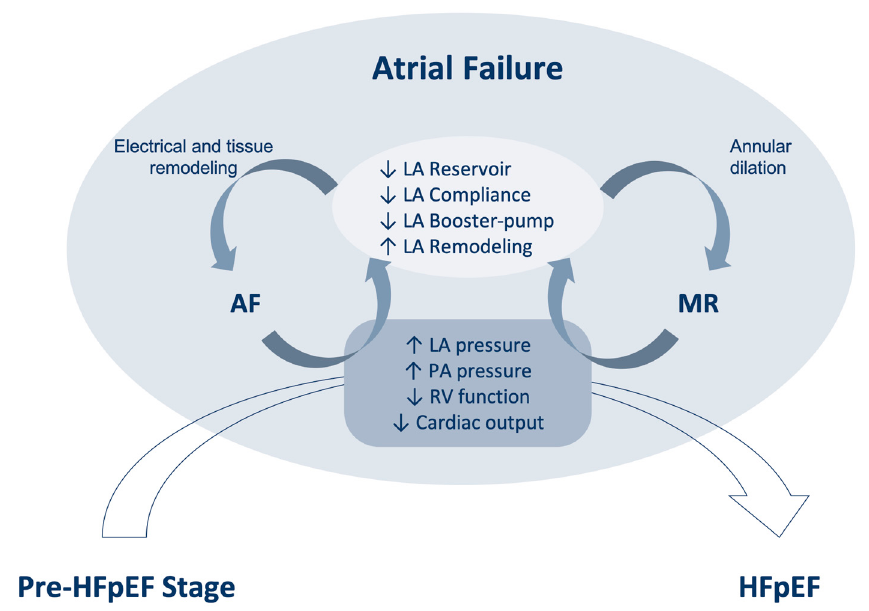
Figure 2. Interaction between atrial failure and the pre-HFpEF stage. Atrial failure is a main driver in transforming the pre-HFpEF stage into clinical HFpEF and is mainly driven by an impaired left atrial (LA) function and structure leading to increase LA and pulmonary artery (PA) pressure. The presence of atrial fibrillation (AF) and mitral regurgitation (MR) represent the rhythm and valvular manifestations of atrial failure syndrome, which further exacerbates the functional impairment of the LA and its hemodynamic consequences with adverse synergy. HFpEF, heart failure with preserved ejection